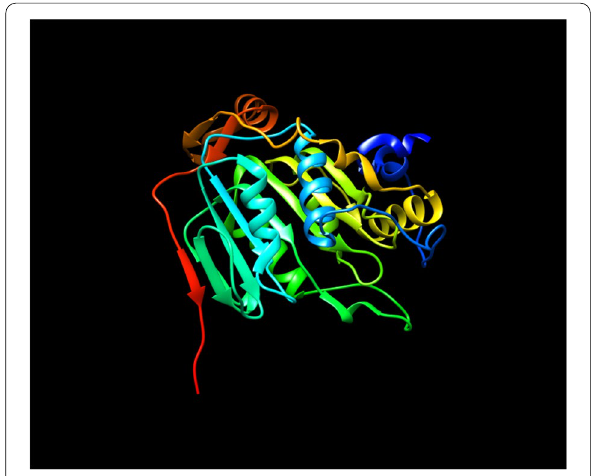
Fig. 1 3D structure of nsp16 free from nsp10 and